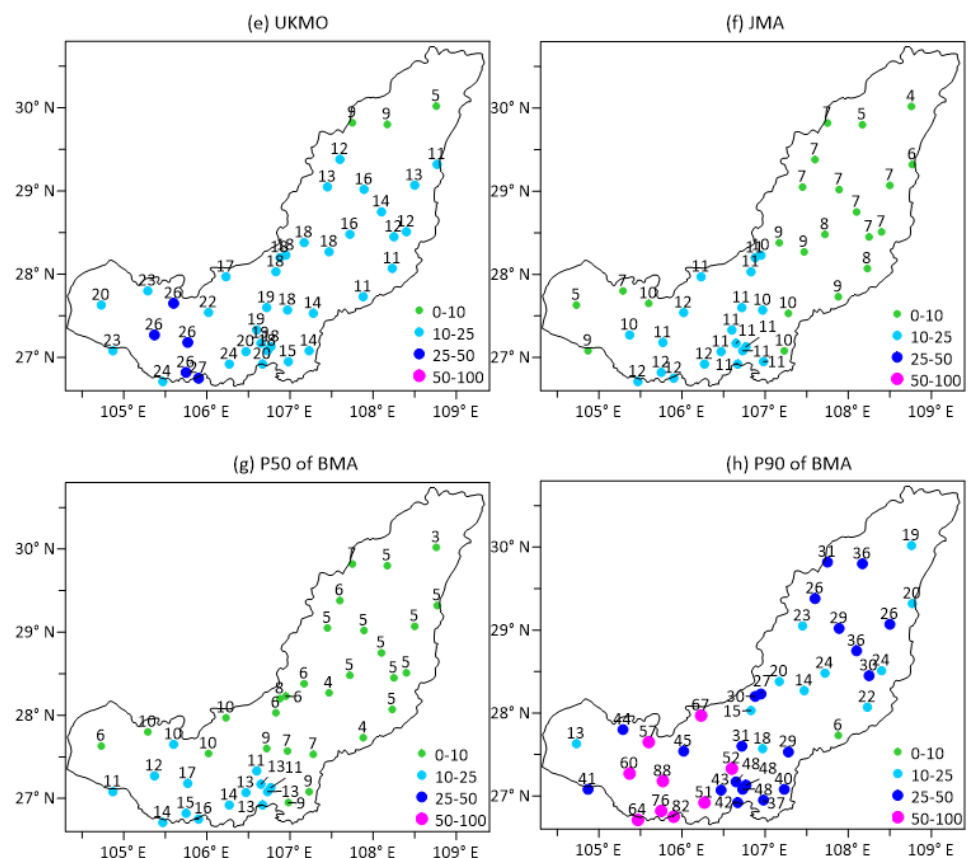
Figure 7. The forecast results and their corresponding observed precipitation distribution ( a ) ensemble average forecasting ( b ) single model ( c ), ( d ), ( e ), ( f ), 50th percentile ( g ), and 90th percentile ( h ) of BMA forecasts. The numerals are the observed precipitation. The colored dots represent the levels of 24 h accumulated observed precipitation, including the light rain (0–9.9 mm, green dots), moderate rain (10–24.9 mm, lake blue dots), heavy rain (25–49.9 mm, blue dots) and rainstorm (50–100 mm, pink dots).